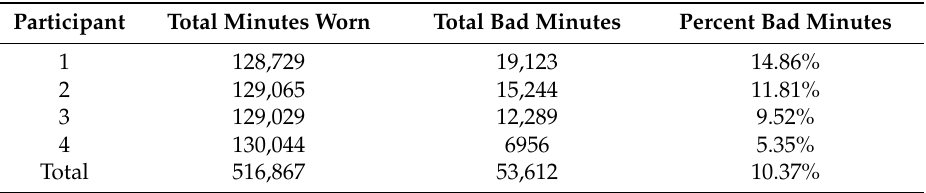
Table 3. Summary of actigraph data